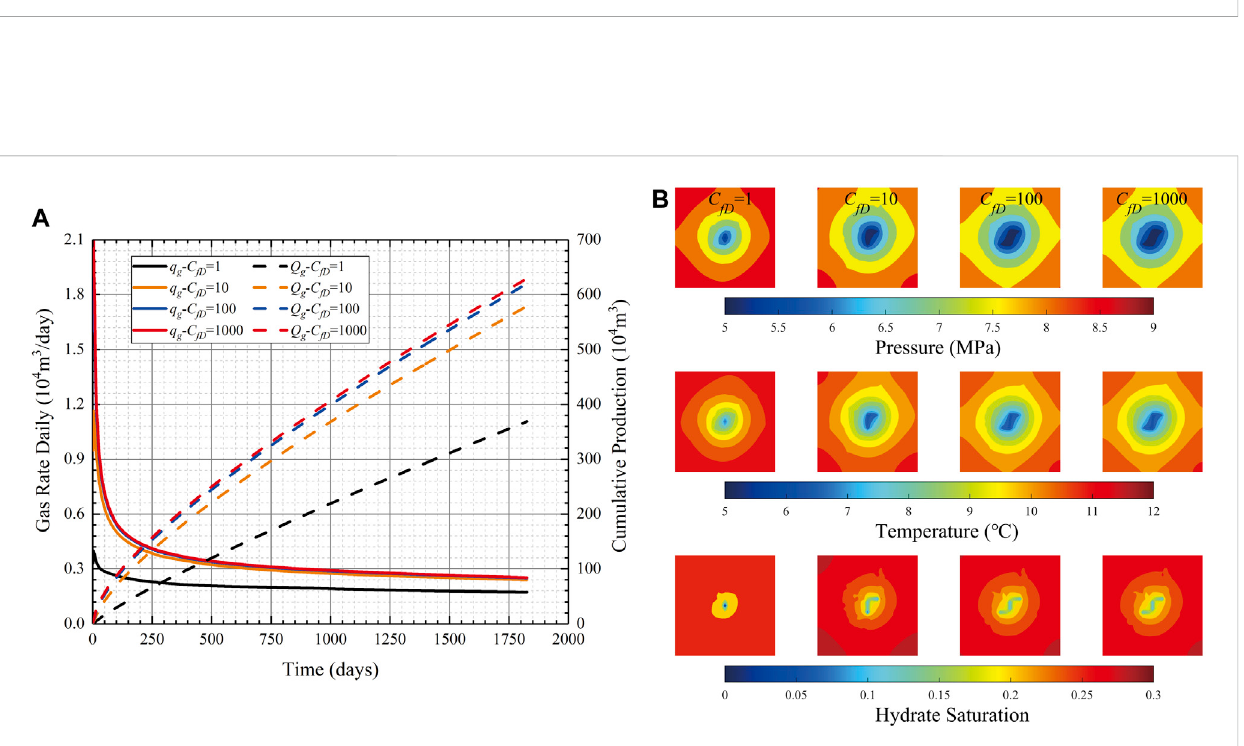
Pressure,temperature,andhydratesaturation fi eldmapsofdifferentscenariosatthe1800thproductionday: (A) differentvaluesof N nf withconstant value of N f_con (B) constant value of N nf with different values of N f_con .